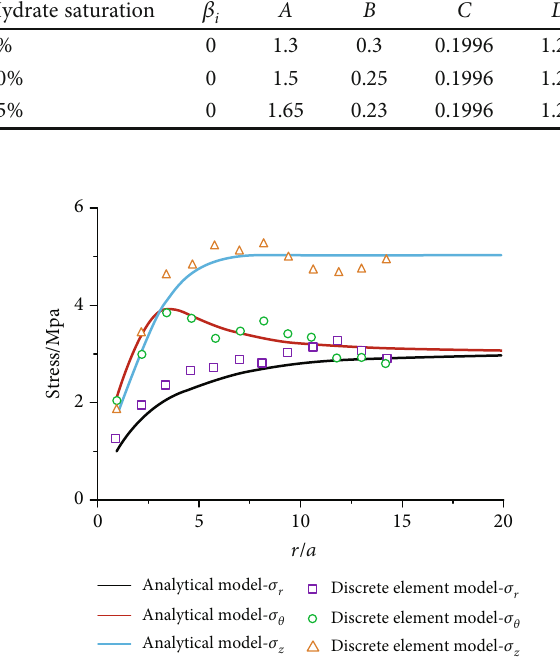
Figure 4: Comparison of calculation results between the analytical model and the discrete element model.